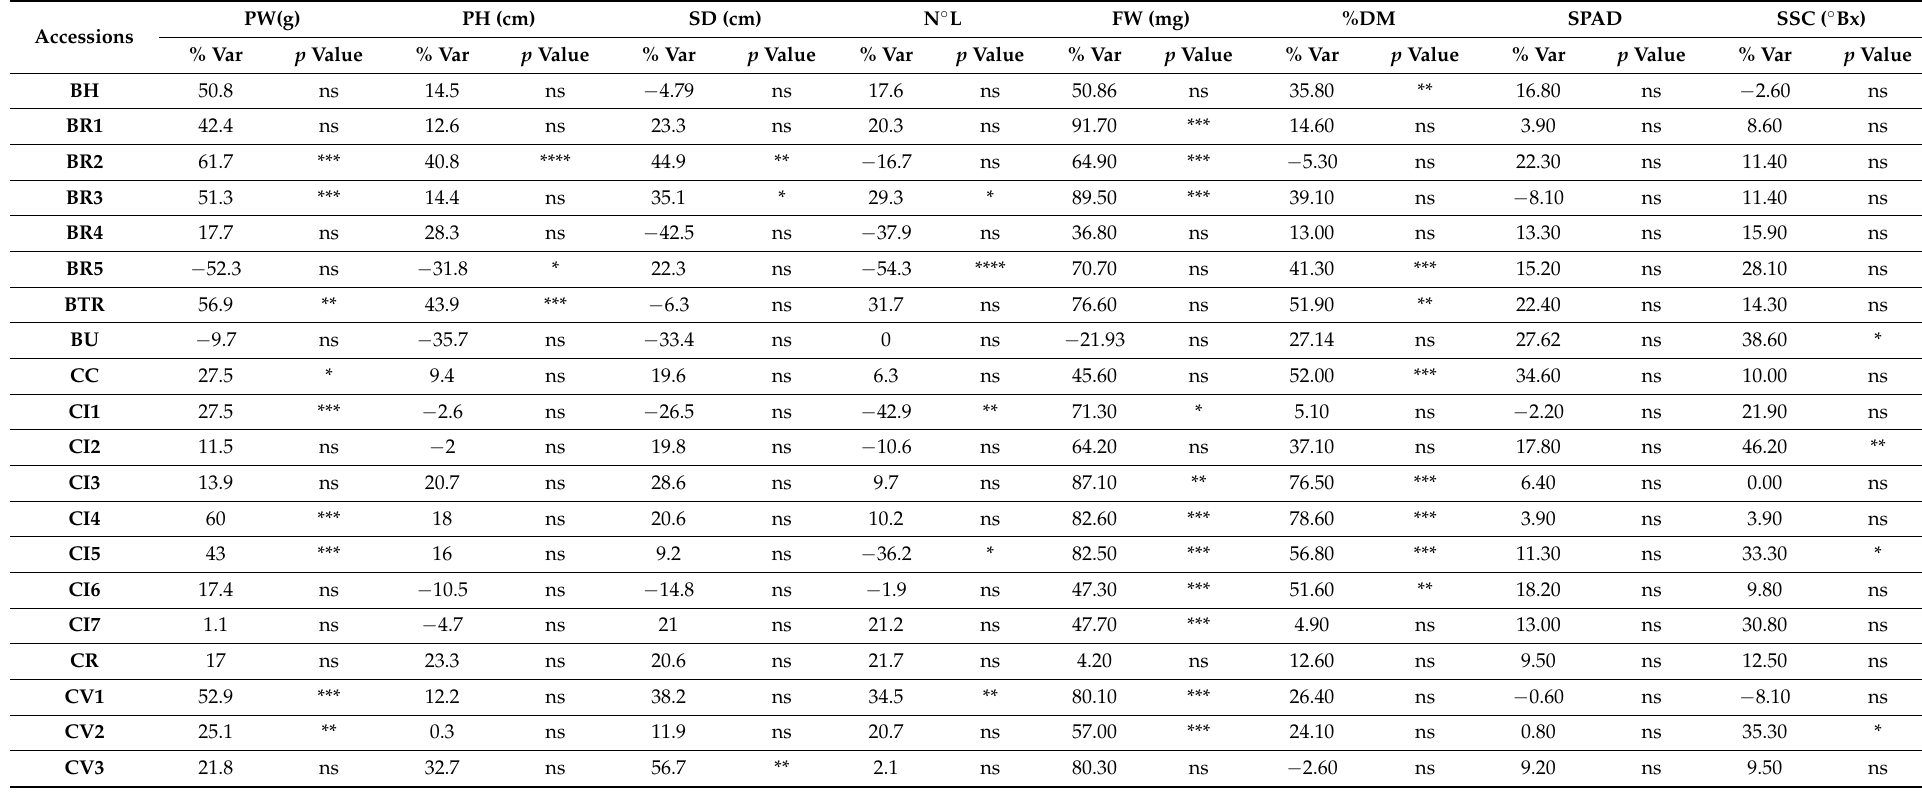
Table 2. Percentage of variance and statistical significance of morphological parameters (%variation = ((control-stress)/control ×